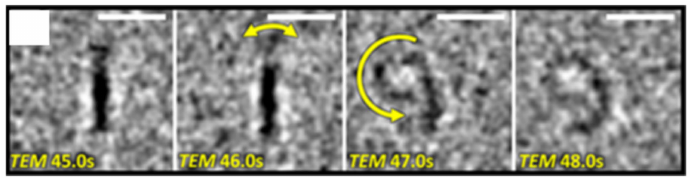
Figure 4. SMART-EM exploration of the molecule-to-molecule transformation of polycyclic aromatic hydrocarbon to C 60 on graphene. Yellow arrows indicate the direction of motion [39]. Copyright 2021, American Chemical